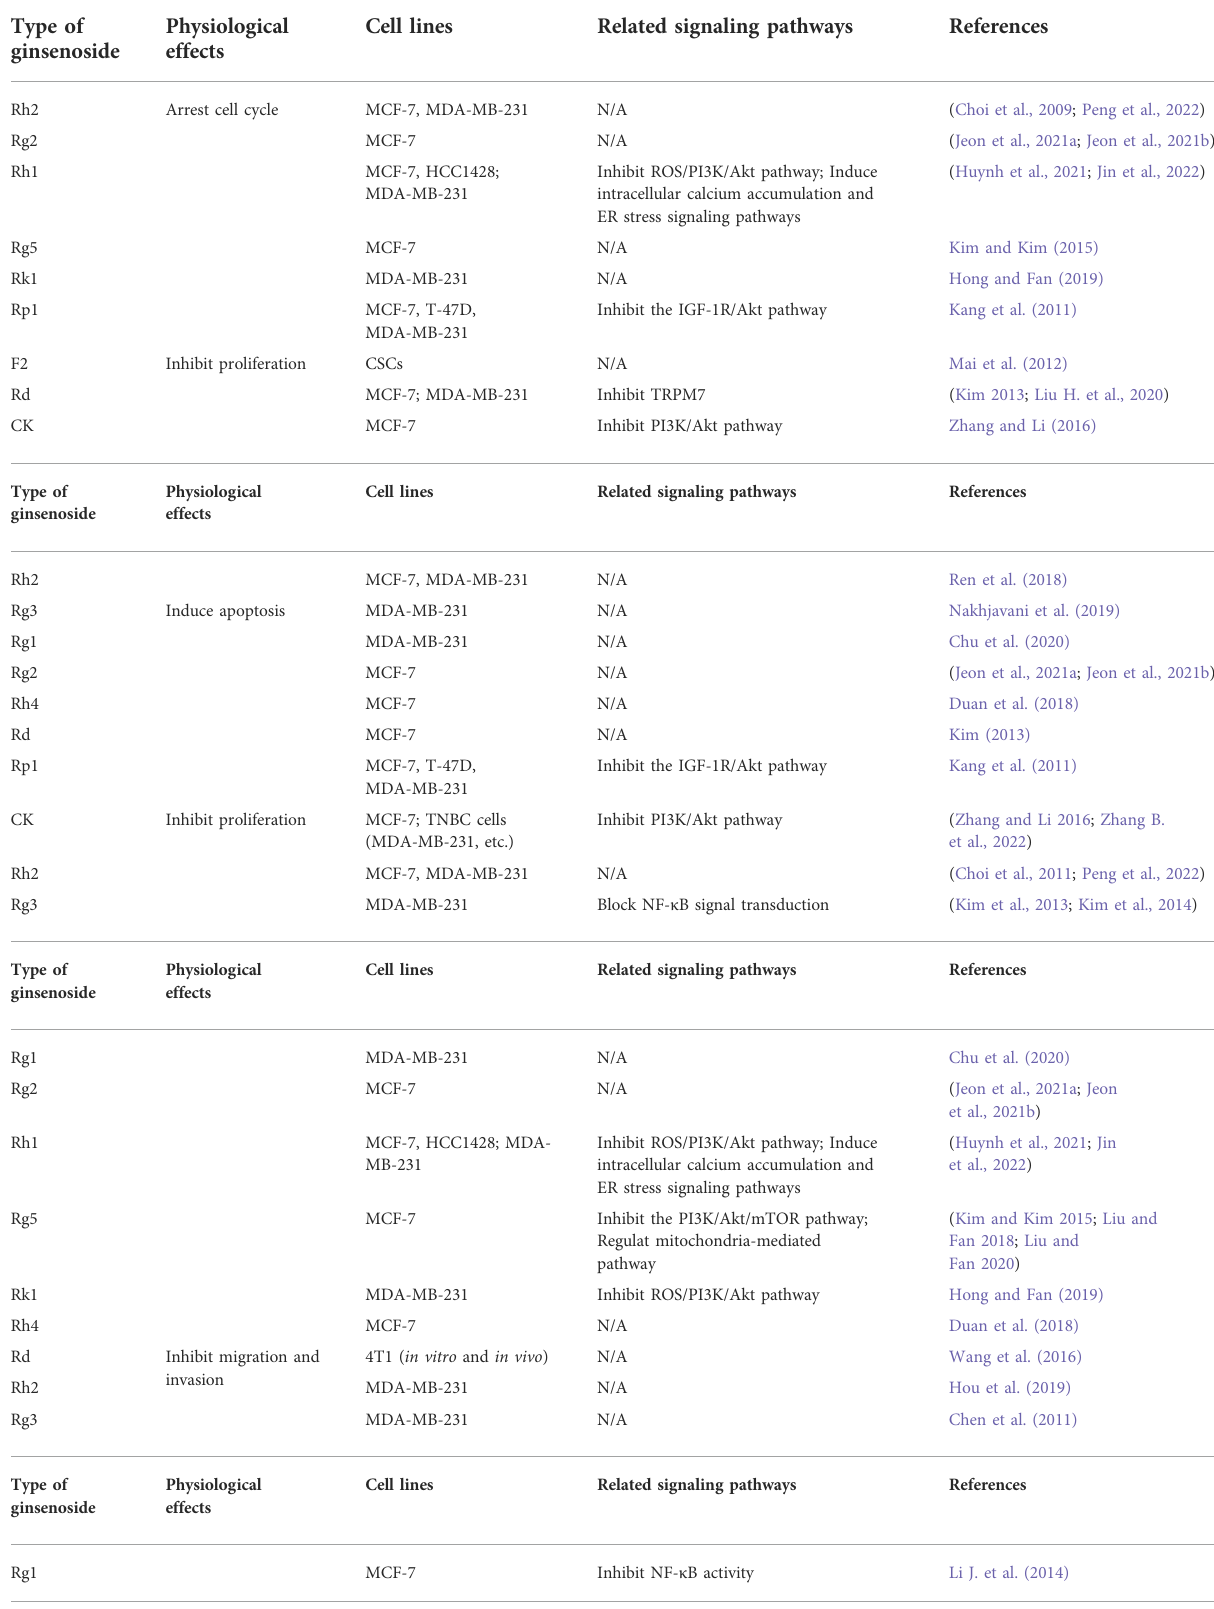
TABLE 1 Inhibition of ginsenosides on breast cancer cells through inducing cell cycle arrest and apoptosis, inhibiting proliferation, migration, invasion, autophagy, angiogenesis and EMT,